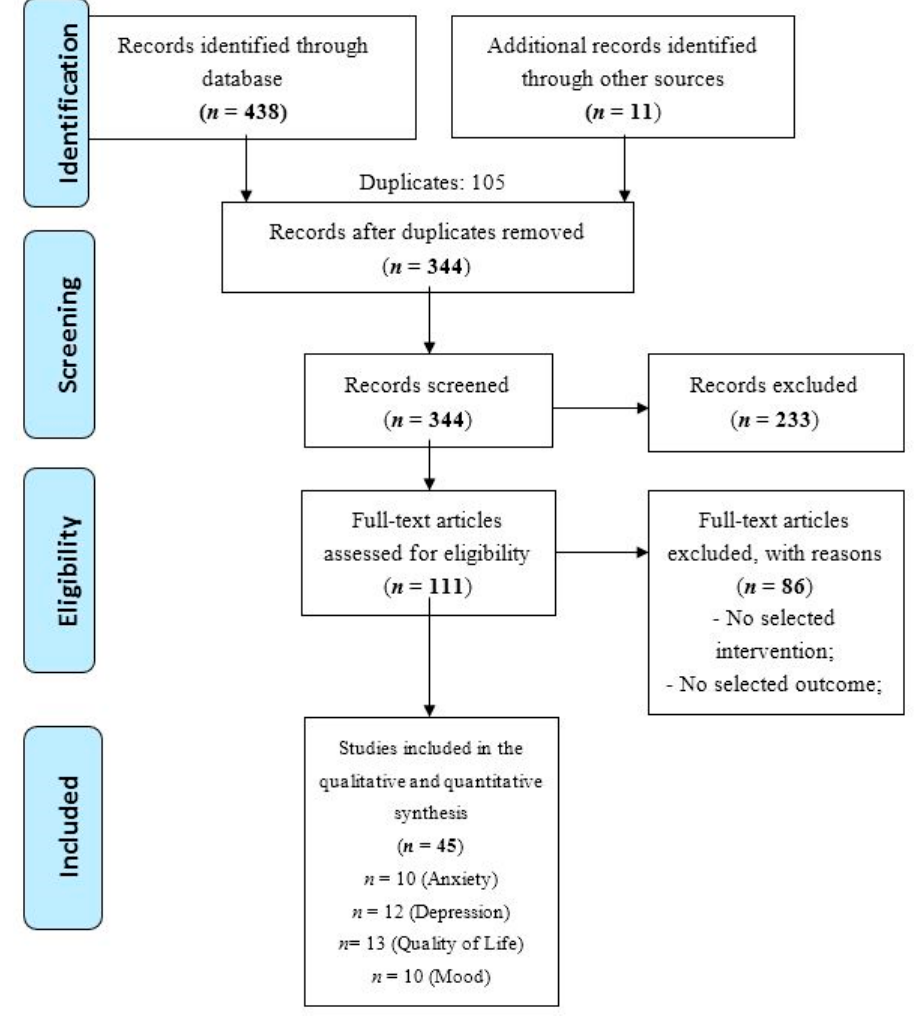
Figure 1. The study screening process.